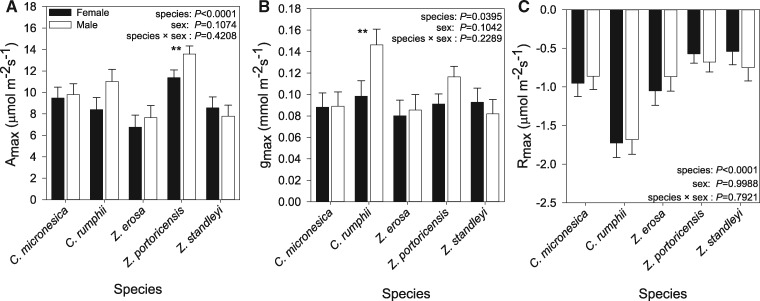
(A) Mean (±1 S.E.) gas-exchange data of photosynthetic maximum (Amax), (B) maximum stomatal conductance (gmax), and (C) maximum respiration (Rmax). White bars represent males, and black bars represent females. Double asterisks indicate a significant difference (P < 0.05); error bars represent standard error of the mean.